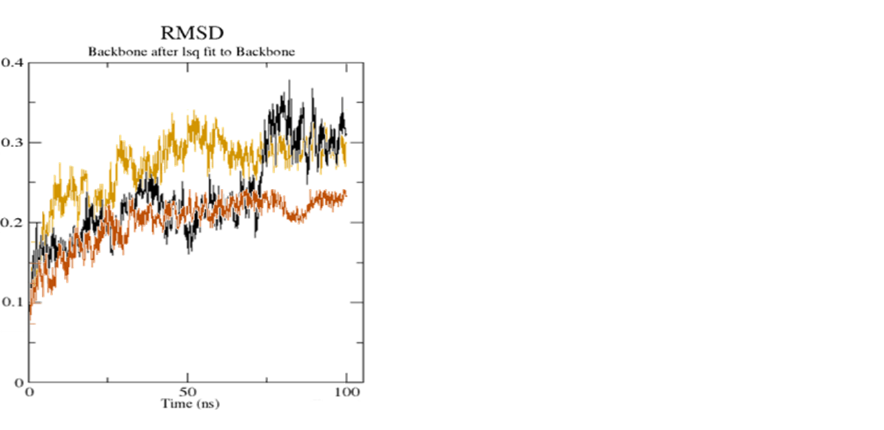
Figure 10. The root mean square deviation (RMSD) of the solvated receptor backbone and ligand complex during the 100 ns MD simulation [unbound serotonin receptor (yellow), GpnS complex (black), and CuGS complex (brown)]. According to the literature, a RMSD value under <3.0 Å is the most acceptable [44]. The drop in the RMSD value for CuGS showed an alteration in the secondary structure conformation of the protein due to the [Cu(II)–(Gpn)] interaction. This finding shows that CuGS developed a more stable combination. The results confirm that this interaction brings protein chains closer and reduces the gap between them, as shown in Figure 11 [45].